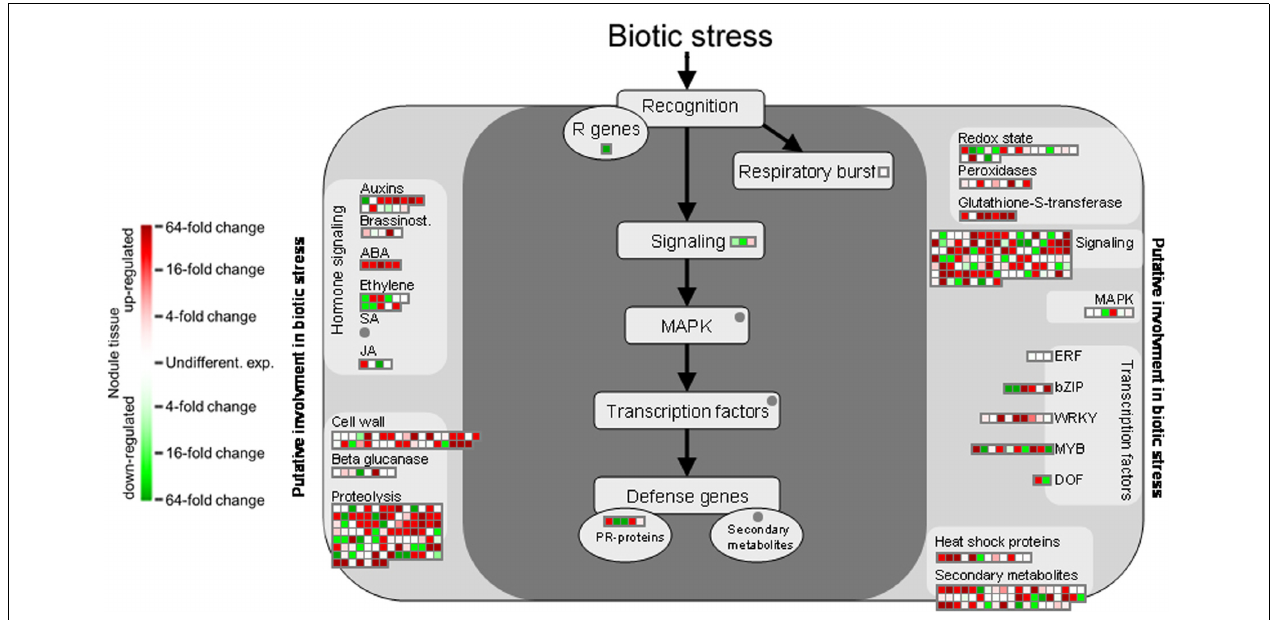
FIGURE 5 | Gene expression relating to biotic stress pathways based on the functional annotation with MapMan. Please consult Figure 4 for further details.